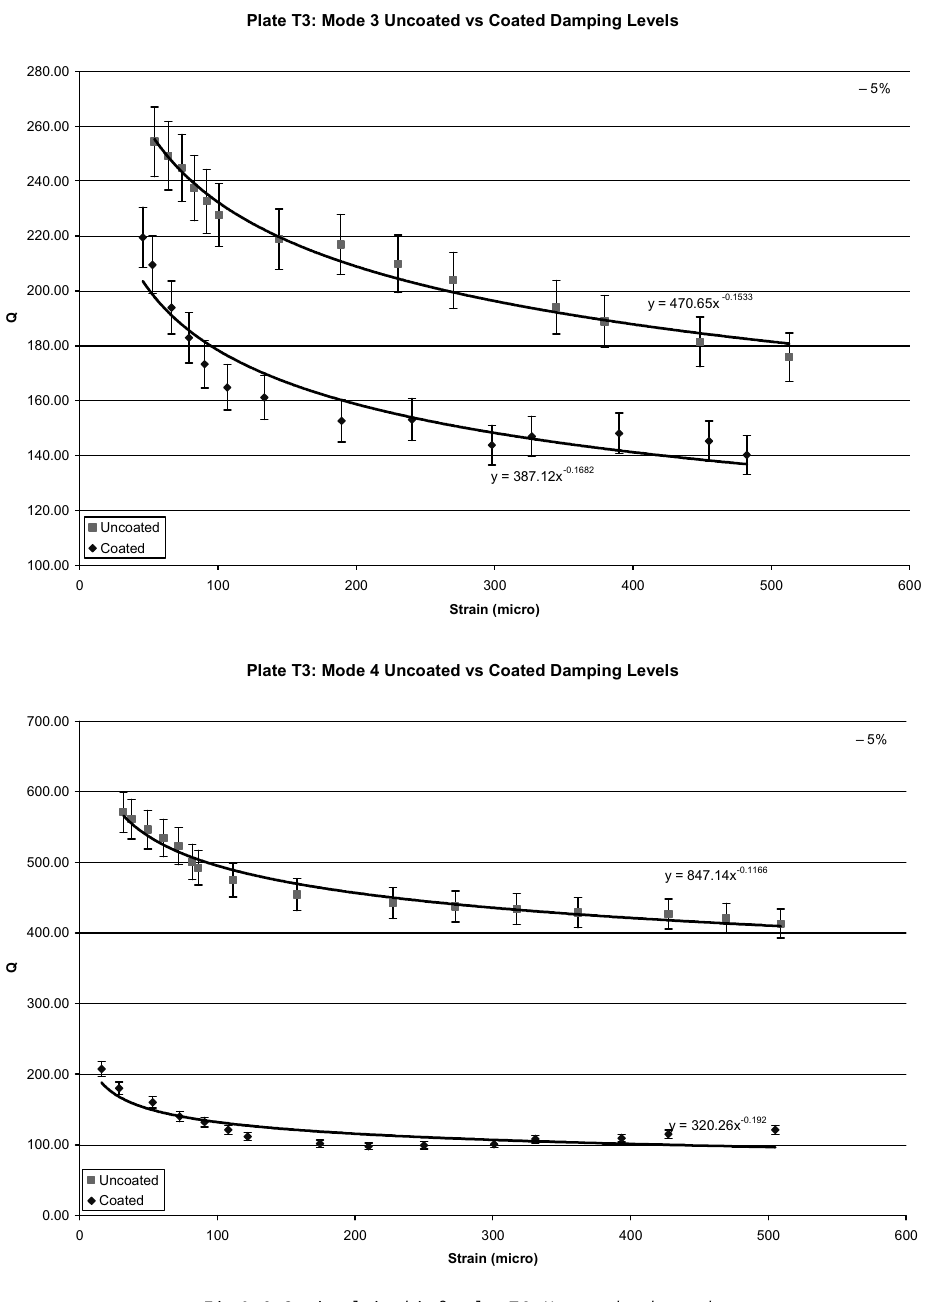
Fig. 9. Q-Strain relationship for plate T3: Uncoated and